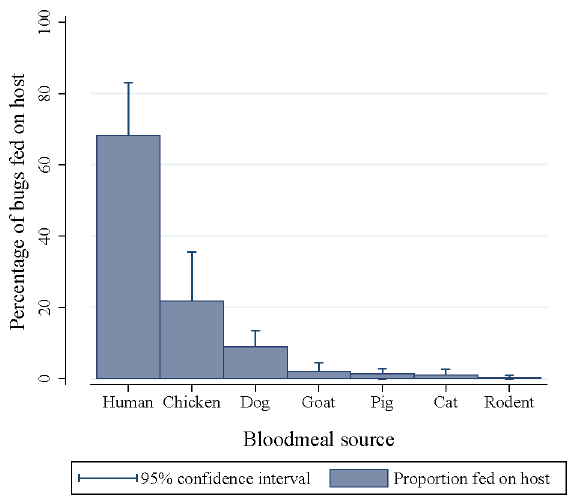
Figure 2. Percentage of late-stage T. infestans collected in human sleeping quarters that fed on each host species (regardless of feeding on other host species). Figueroa, spring 2003. 95% confidence intervals clustered by site.